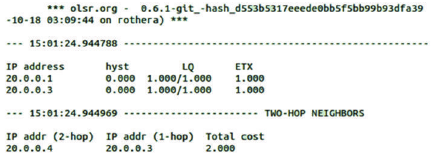
Figure 3: Route establishment by OLSR.